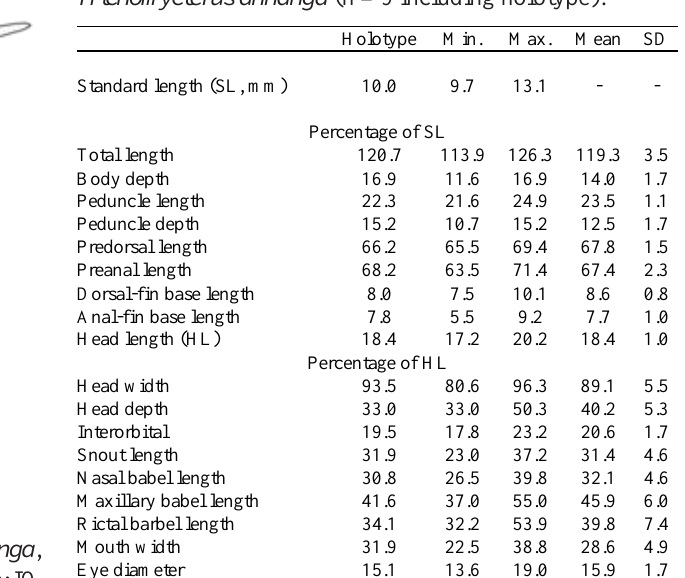
Table 1. Morphometric data for holotype and paratypes of Trichomycterus anhanga (n = 9 including